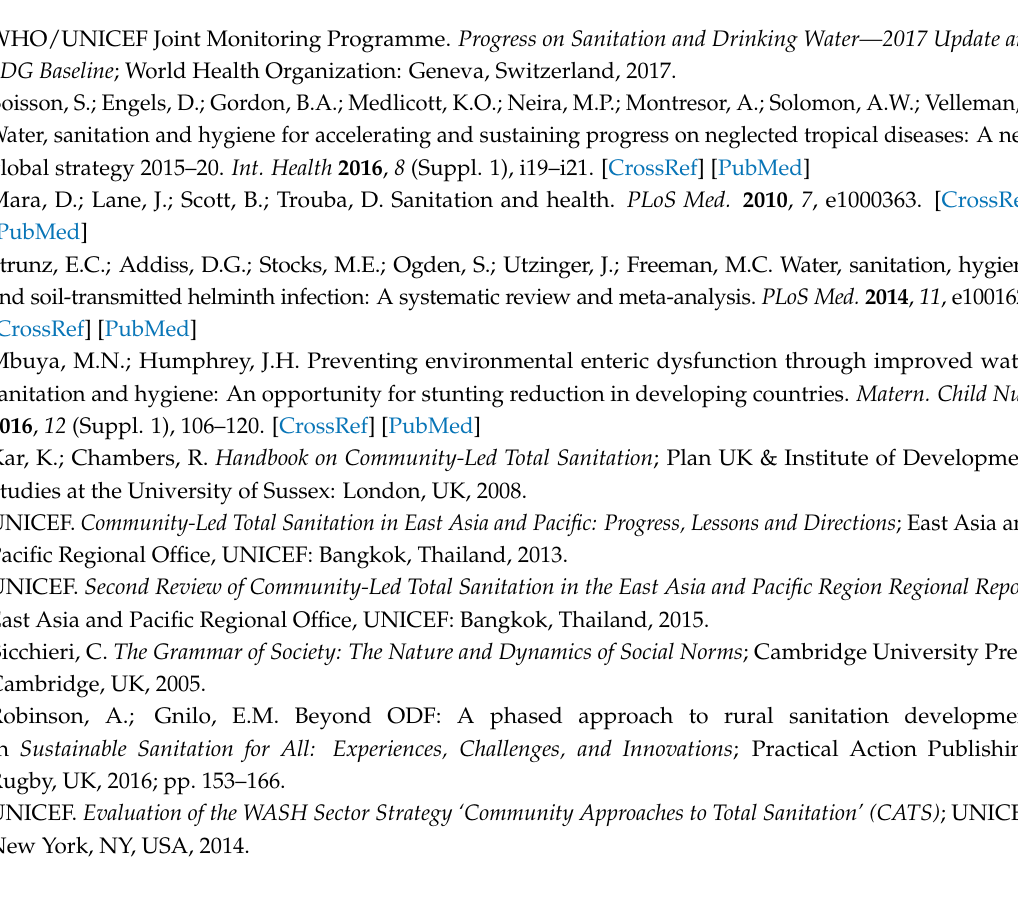
latrine ownership. Table S4: Summary of Focus Group Discussion (FGD) findings in 6 ODF verified villages, Figure S1: Relative proportion of household types among households that were classified as having slipped